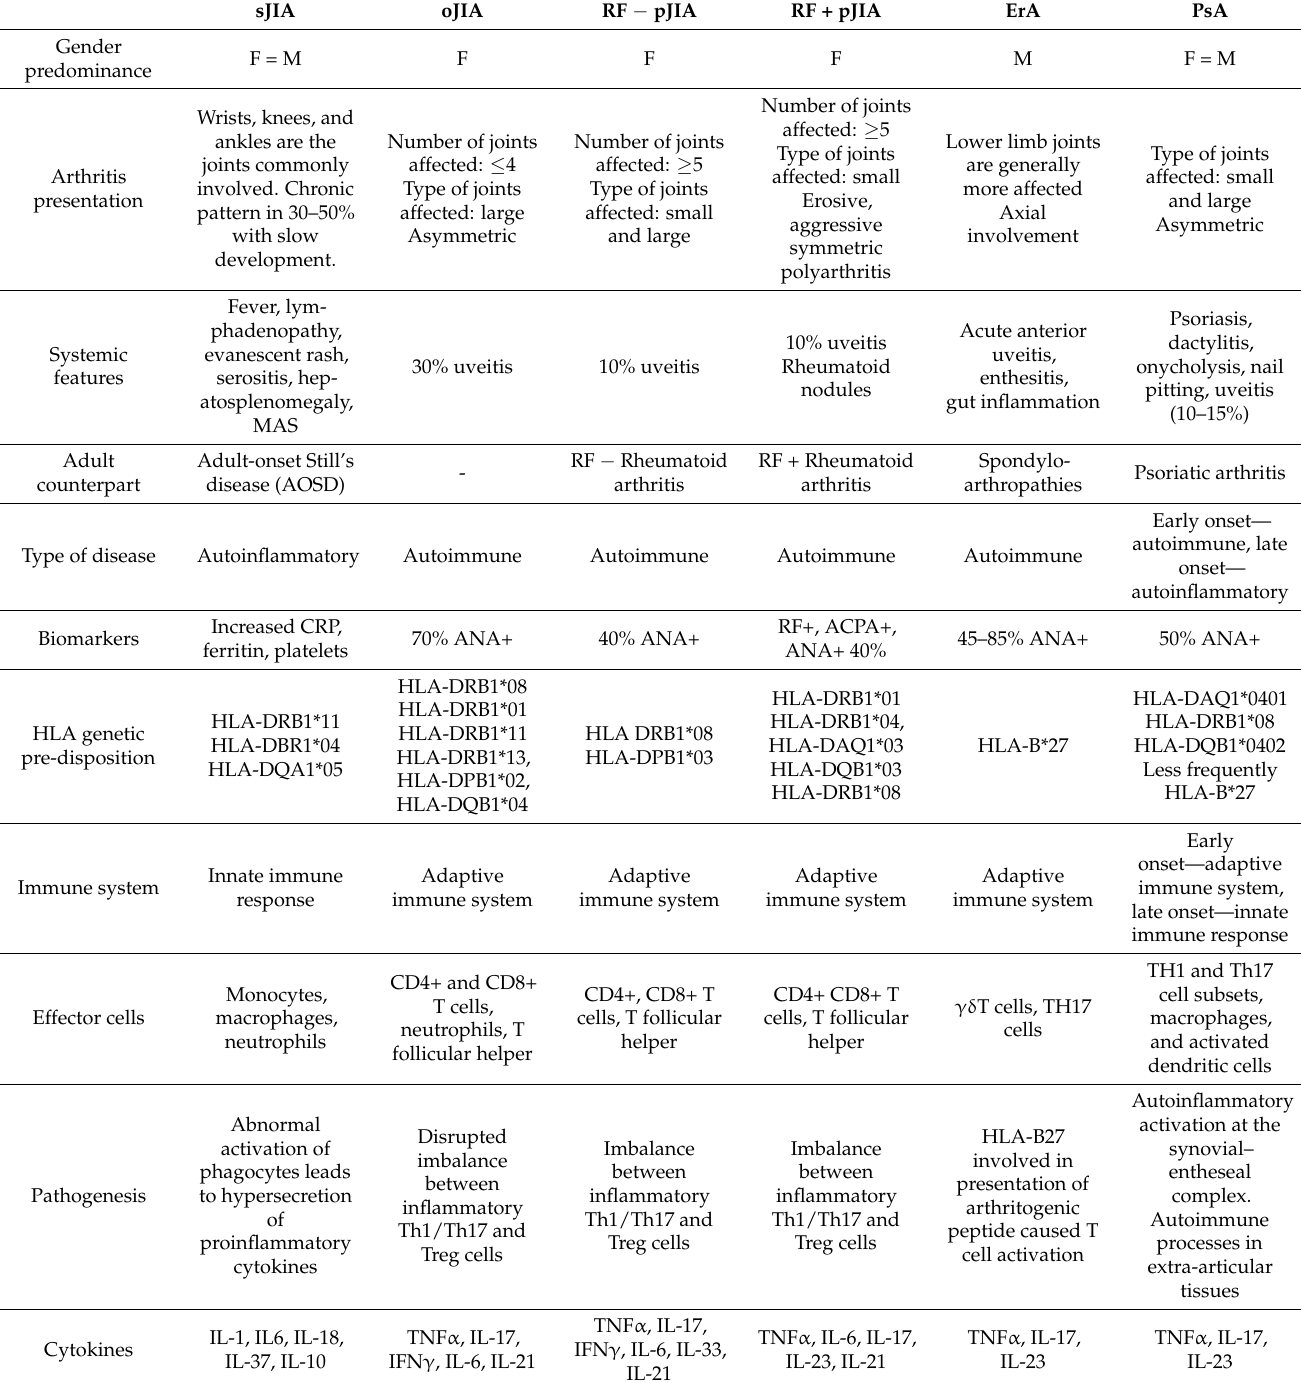
Table 1. Summary of arthritis characteristics and systemic features in the different JIA subtypes with a focus on cytokines involved in the aetiopathogenesis (adapted by Zaripova et al.